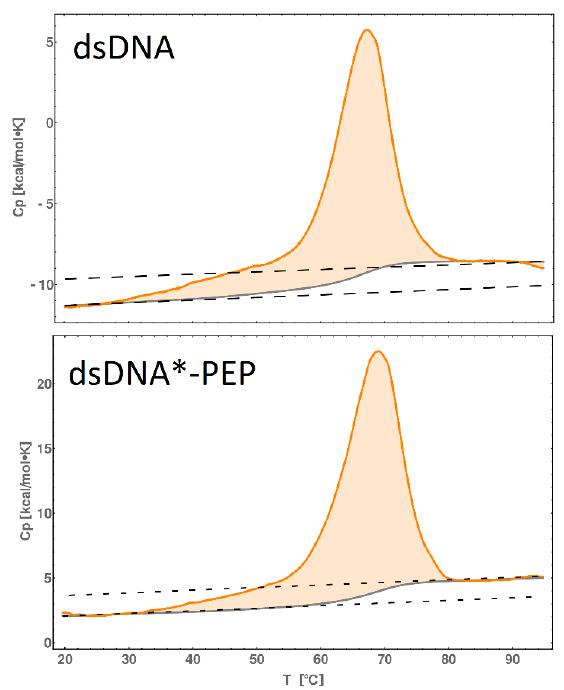
Figure 9. Thermograms for dsDNA and dsDNA*-PEP (orange line) and baseline (gray line) of dsDNA and dsDNA-PEP in 100 mM PBS solution. Dashed lines indicate the heat capacity difference between folded and unfolded states. The DSC spectra after the sigmoidal baseline subtraction are shown in supplementary material (Figures S3 and S4). DSC experiments were performed on the CSC 6300